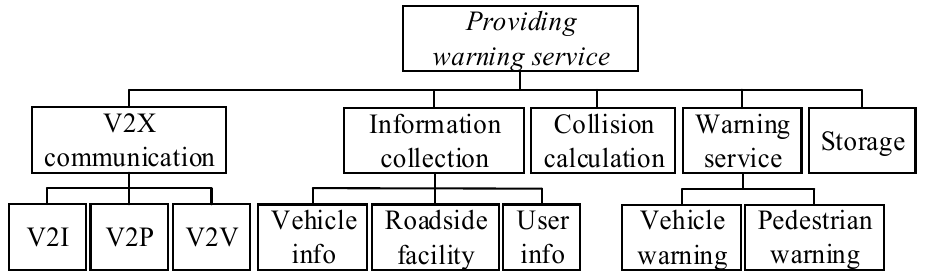
Figure 11. Functions of extended CWS from the perspective of smart PSS.